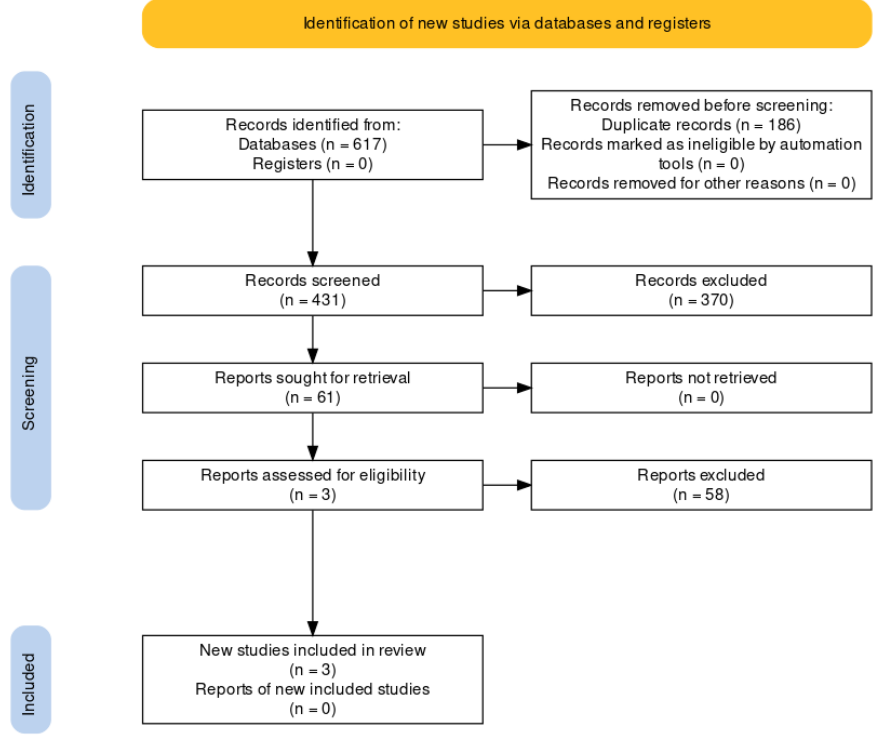
Figure 1. PRISMA flow diagram of the procedures made to extract the works evaluated.